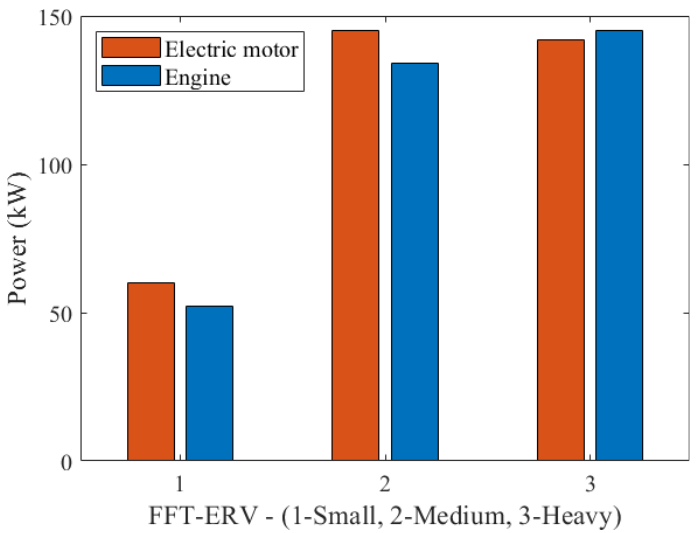
Figure 11. SVM classification of motor and engine power of a foam fire truck emergency rescue vehicle.